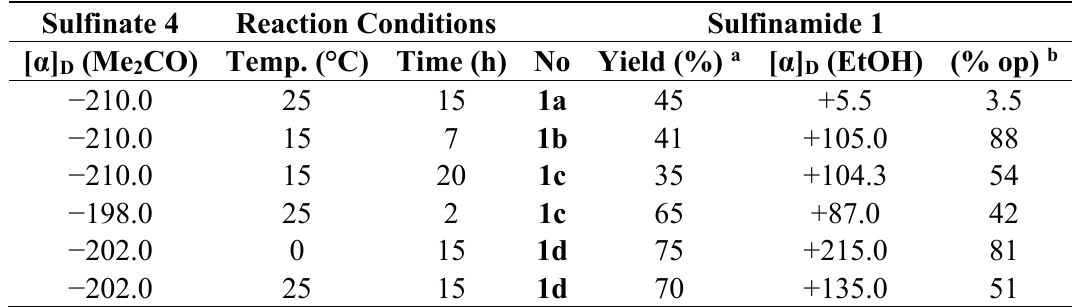
Table1. Stereoselective synthesis of p -toluenesulfinamides 1 from ( − )-( S )-menthyl p -toluenesulfinate ( 4 ).